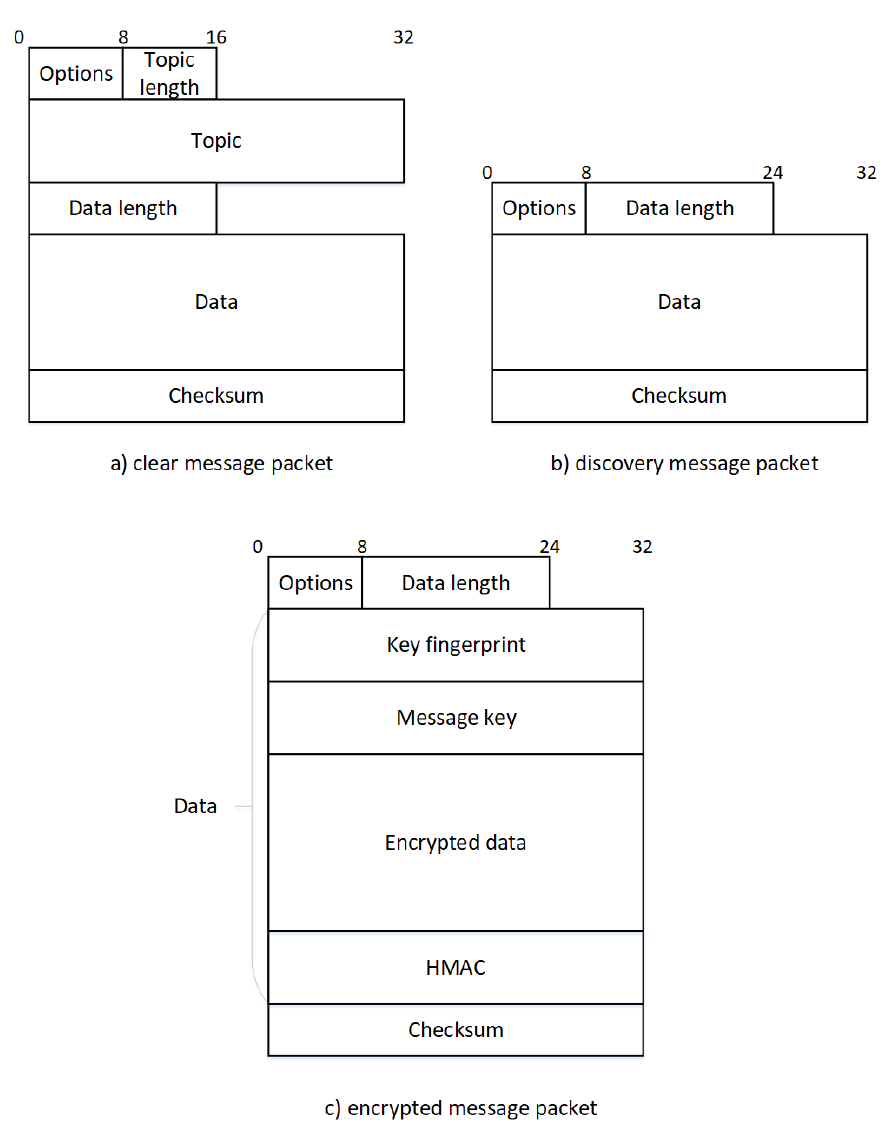
Figure 4. Representation of the three packets present in our protocol. Where ( a ) represents a message going through the network without encryption, ( b ) represents a standard network discovery packet and ( c ) a message going through the network using a secure algorithm to encrypt the main data. HMAC: hash message authentication